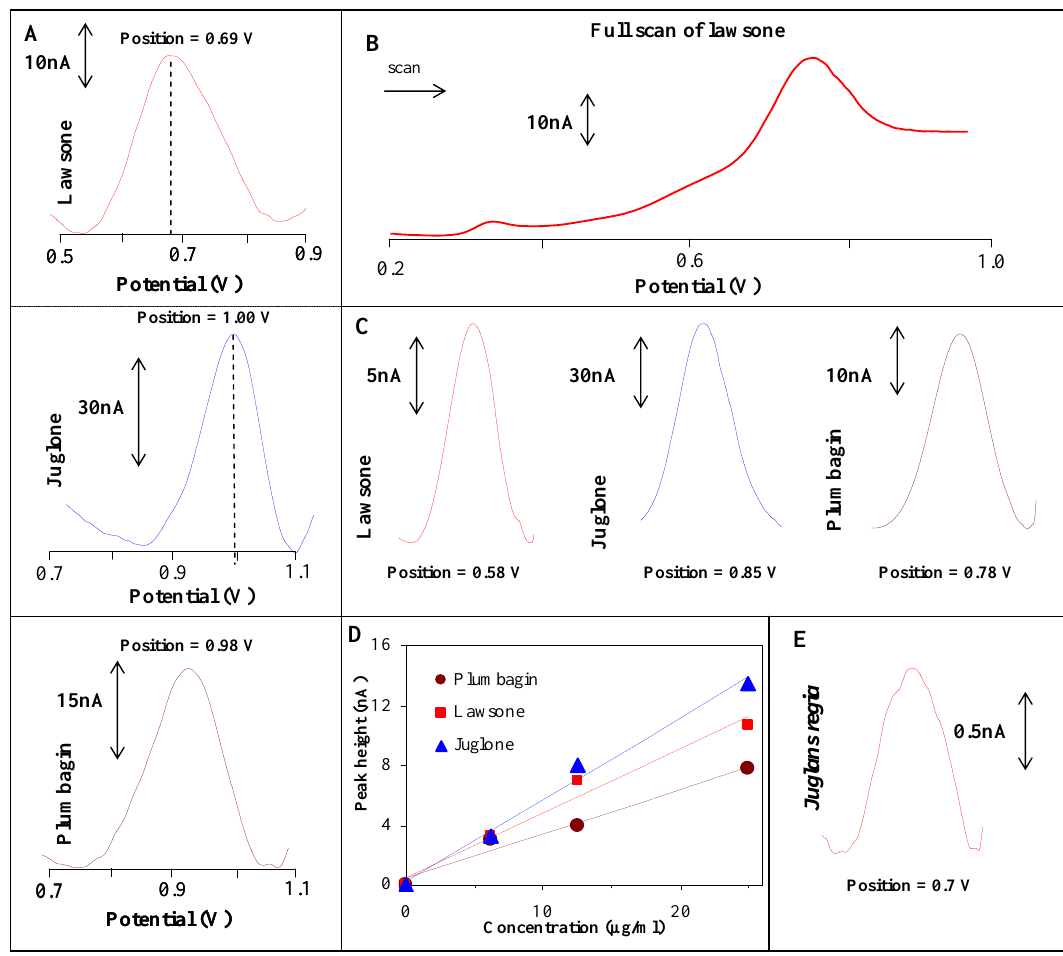
Figure 3. Carbon paste electrode. ( A ) Baseline corrected DP voltammograms of lawsone, juglone and plumbagin (1 µg.ml -1 ) measured on the surface of carbon paste electrode. DPV parameters were used as